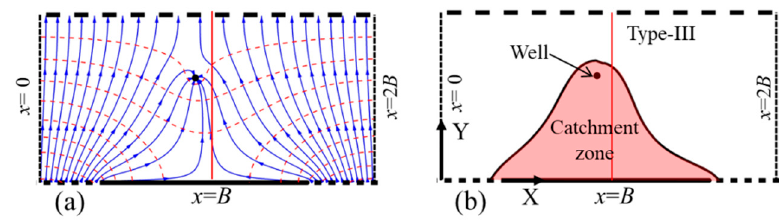
Figure 5. The flow net ( a ) and catchment zone ( b ) of type-III.